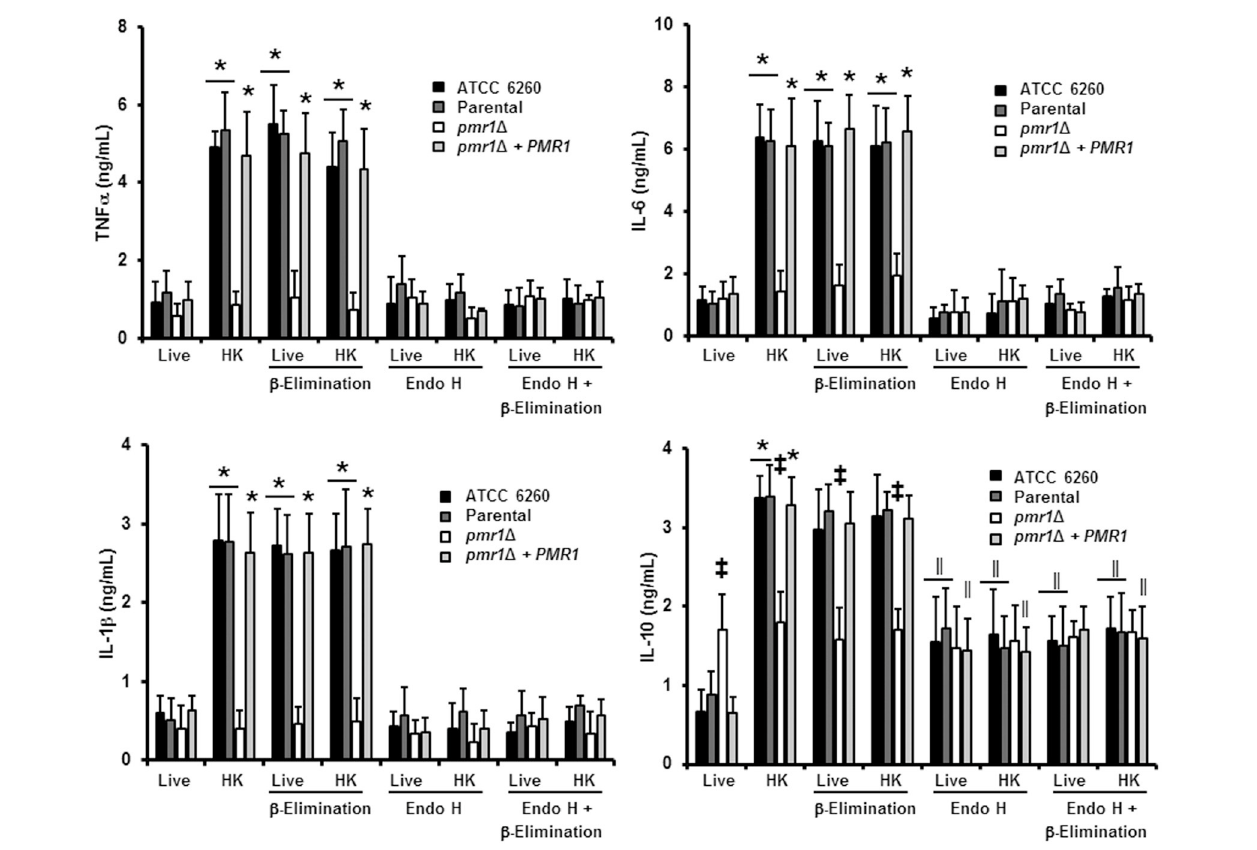
FIGURE 6 | The loss of proper cell wall mannosylation affects the ability of C. guilliermondii to stimulate cytokine production by human PBMCs. Fungal cells were co-incubated with human PBMCs, the supernatant saved and used to quantify pro- and anti-inflammatory cytokines. Results (means ± SD) were obtained using samples from six donors, each assayed in duplicate wells. The strains used are: ATCC 6260, KU141 (Parental), HMY134 ( pmr1 1 ) and HMY138 ( pmr1 1 + PMR1 ) * P < 0.05, when compared with live cells; ‡ P < 0.05, when compared with cells subjected to the same treatment; || P < 0.05, when compared with untreated yeast